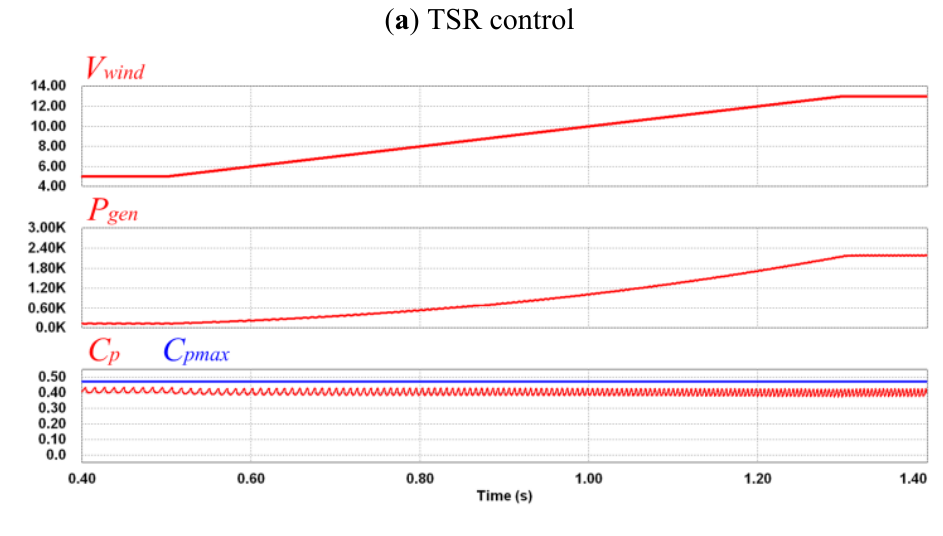
Figure 10. Comparison of dynamic performance with each MPPT method. ( a ) TSR